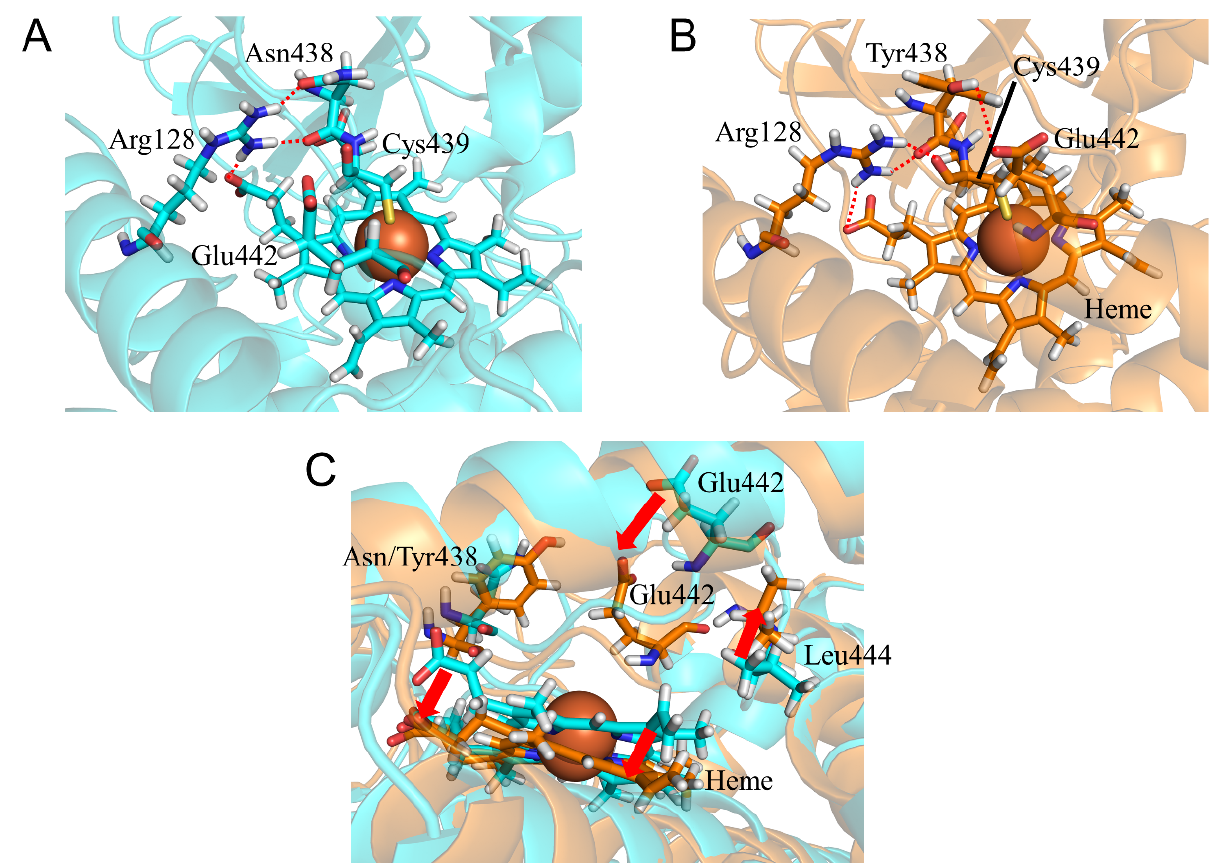
Figure 9. Structural change in CYP2A6.35 ( A – C ). The wild type and CYP2A6.35 are shown in cyan and orange, respectively. Nitrogen, oxygen, and hydrogen are displayed in blue, red, and white, respectively, in the stick model. Iron is shown as an orange sphere by a model written as van der Waals radius. The red dotted lines indicate the hydrogen bonds. The red arrows indicate the shift in CYP2A6.35. Table 7. Hydrogen bond formation involved in the structural change in CYP2A6.35, CYP2A6.36,